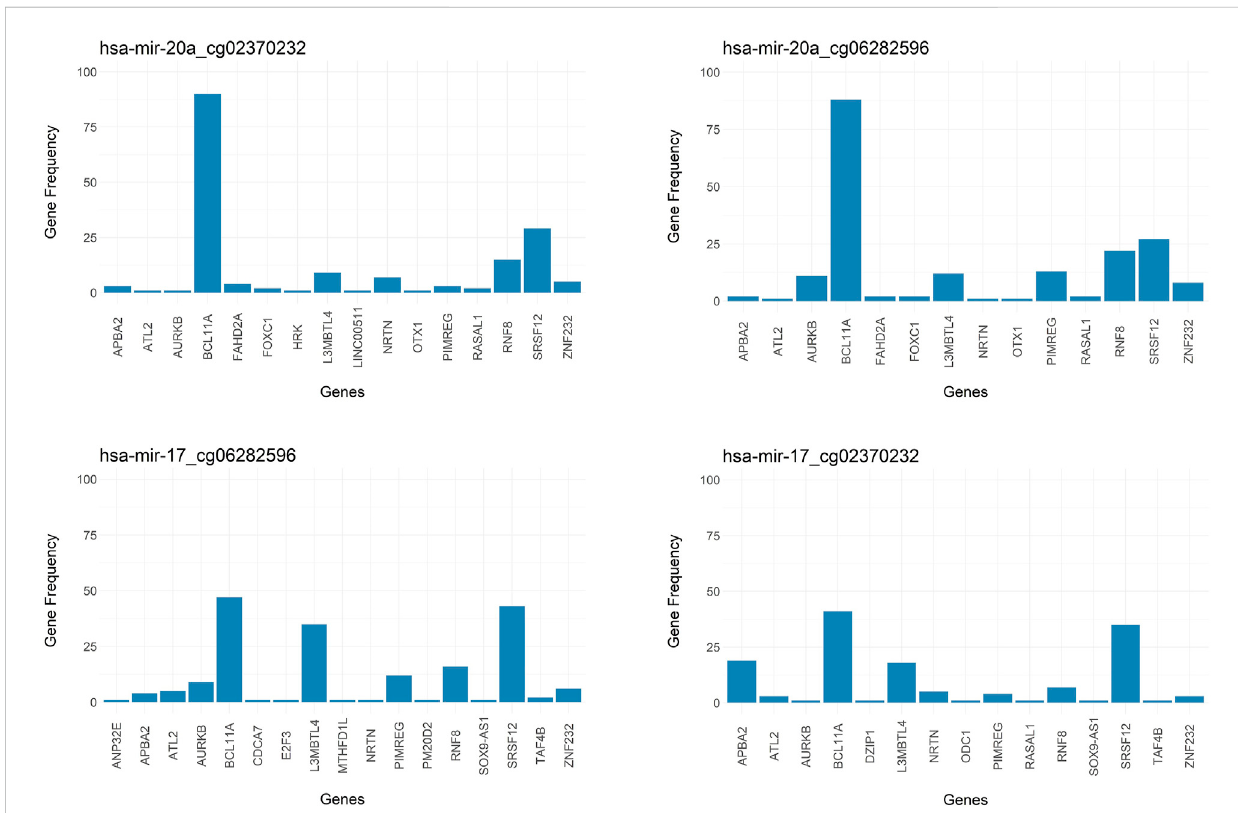
FIGURE 8 Bar graph of frequency of genes over splits for most signi fi cant groups. Targeted genes by the groups of (A) hsa-miR-20a_cg02370232, (B) hsa- miR-20a_cg06282596, (C) hsa-miR-17_cg06282596, (D) hsa-miR-17_cg02370232 are represented in frequency